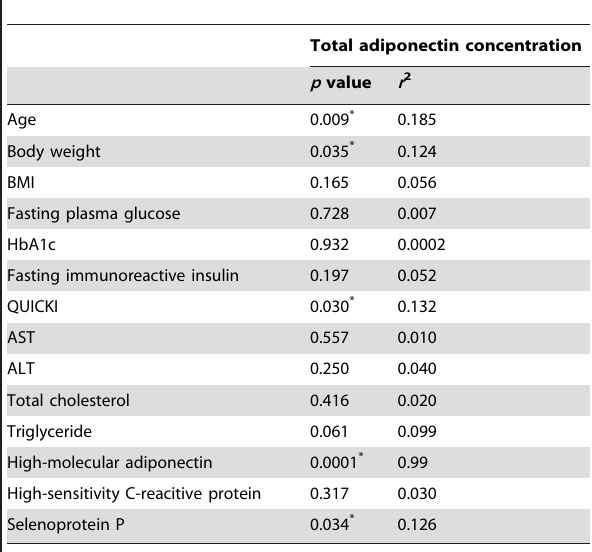
Table 4. Linear regression analysis of total adiponectin concentrations with clinical parameters.